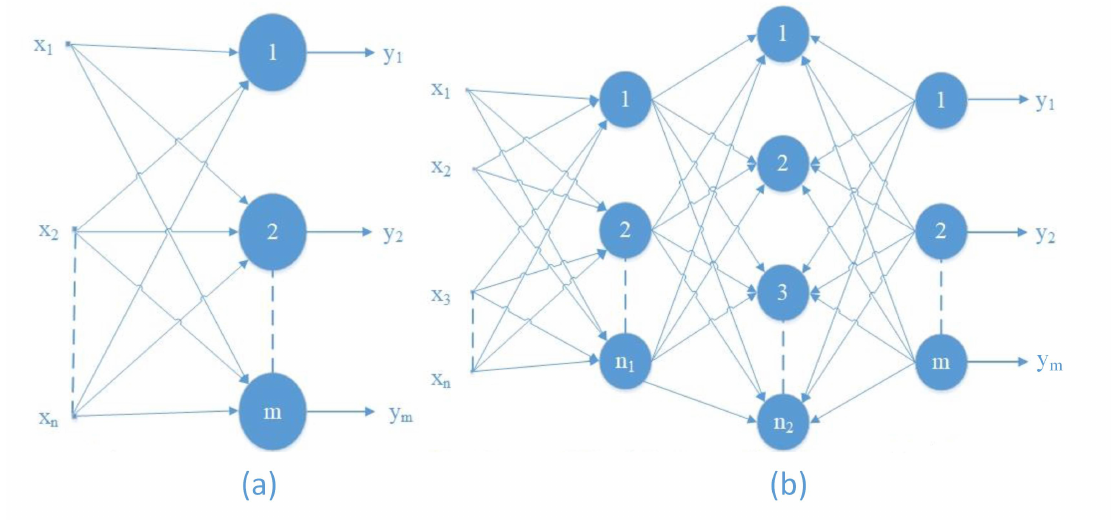
Figure 1. Types of Fully Connected Networks. ( a ) Single Layer Network; ( b ) Multi Layer